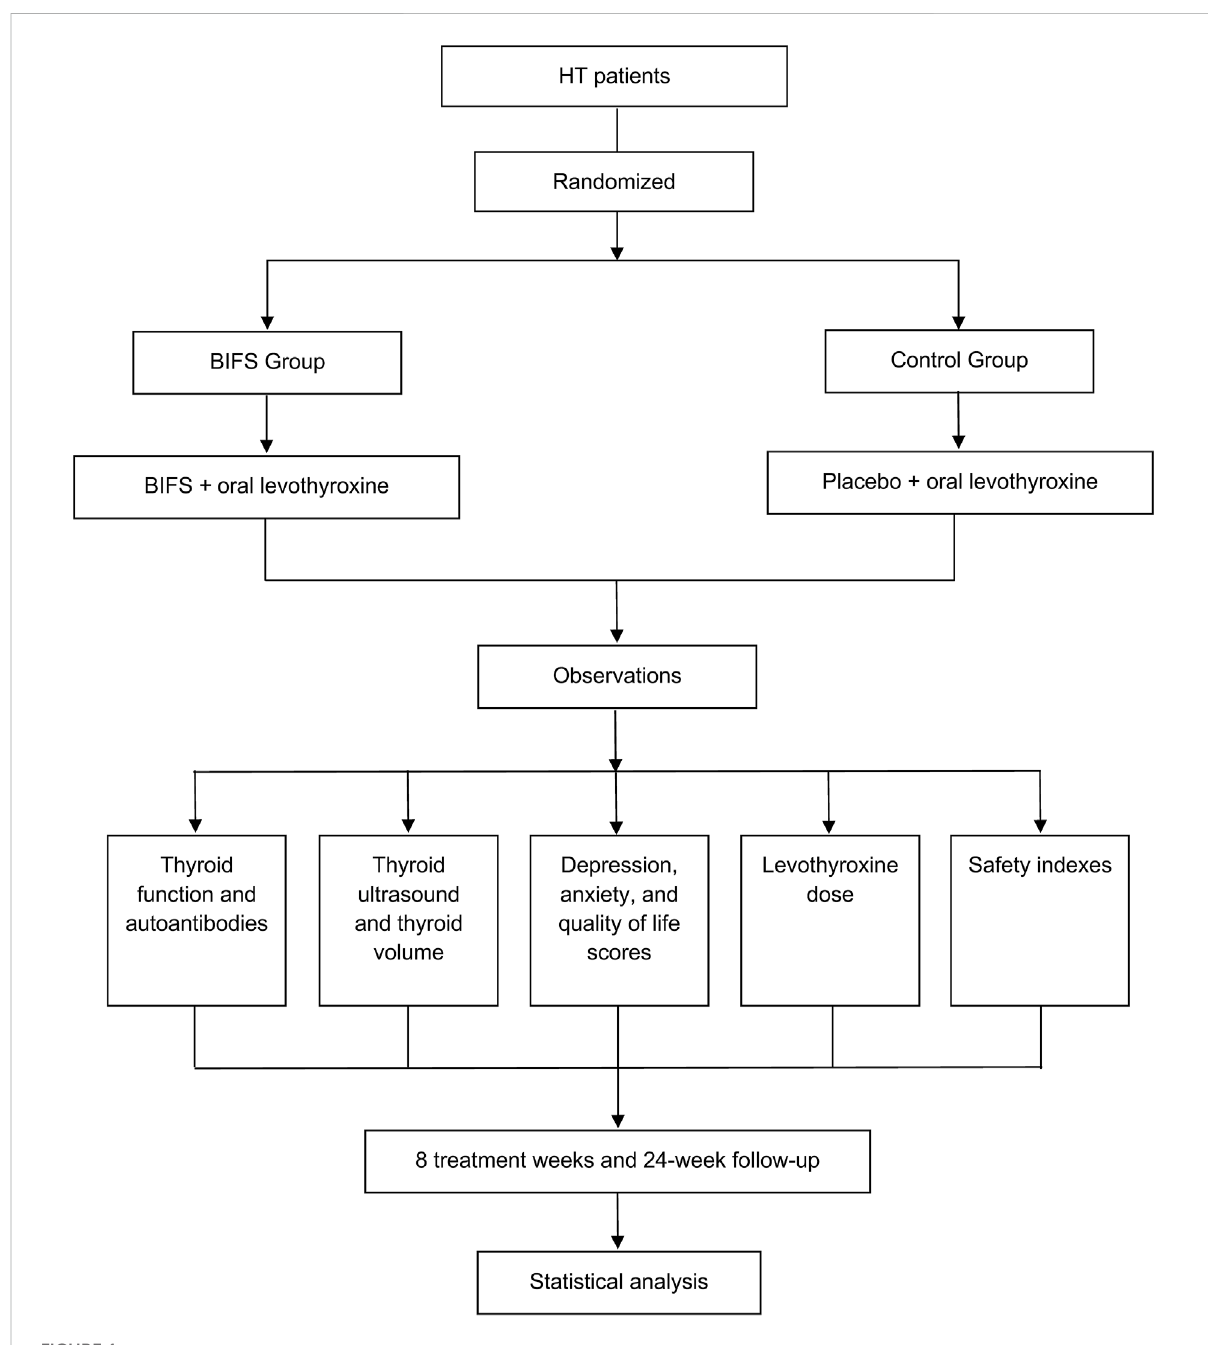
FIGURE 1 Clinical trial fl